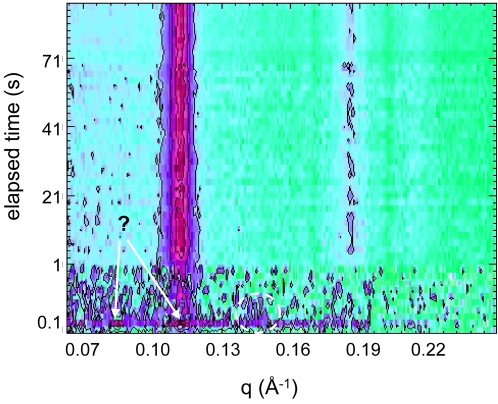
Time-resolved X-ray pattern of the calcium induced H2 phase formation at 20°C.The vesicle dispersion contained DOPG/MO with a molar ratio 30∶70 (7 wt% lipid), and the final salt concentration was 34 mM. The contour plot displays the first three reflections of the H2 phase, but its formation is not immediate. In the first 400 ms, an intermediate phase is apparent. Two strong reflections are indicated by arrows and one weaker peak is circled by a dashed line.